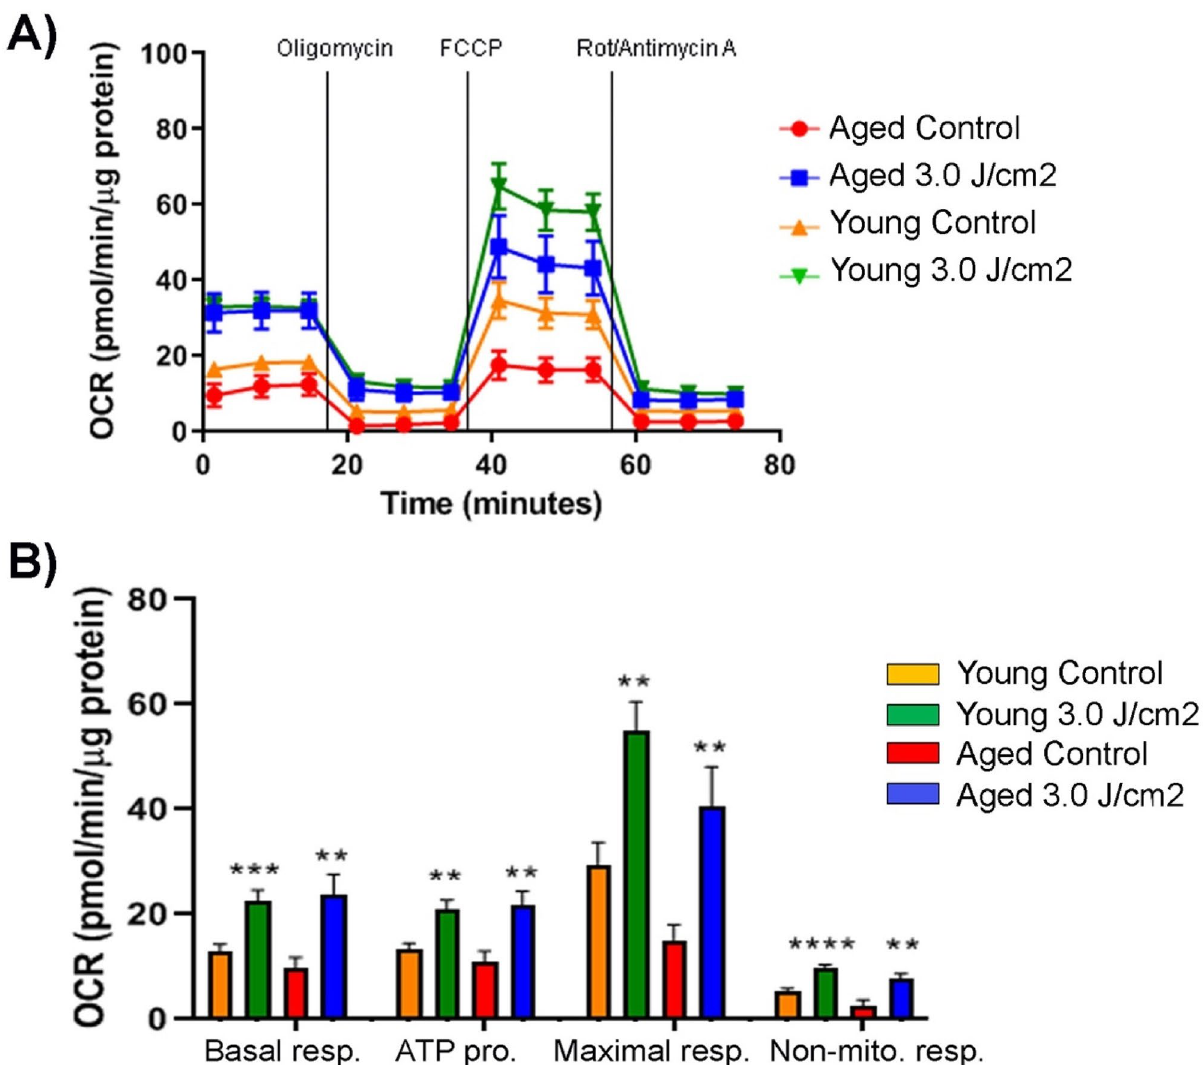
Figure 4. Comparison of short-term effects of PBM on young and aged MSCs. Both young and aged MSCs underwent a PBM treatment at 3 J/cm 2 and their mitochondrial response was determined 3 h later along with that of untreated controls. Data were normalized to μg of protein. Shown are basal respiration, ATP production, maximal respiration, and non-mitochondrial respiration of young and aged MSCs as an OCR curve ( A ) and as a bar graph ( B ) with significant differences labeled. The bars represent means ± standard error of mean. ** p < 0.01; *** p < 0.001; **** p <